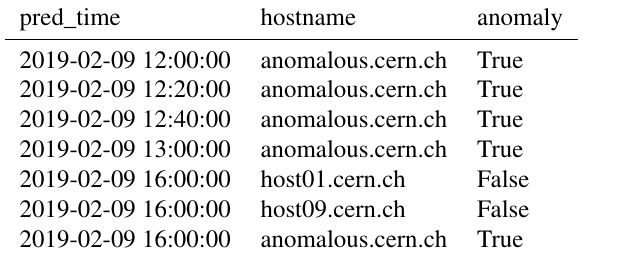
Table 3: All anomalies marked by applying the three-sigma rule to the first dimension error of the Random Forest regressor on a day with a service stop anomaly. The anomaly started at 12:00 and ended at 16:00.